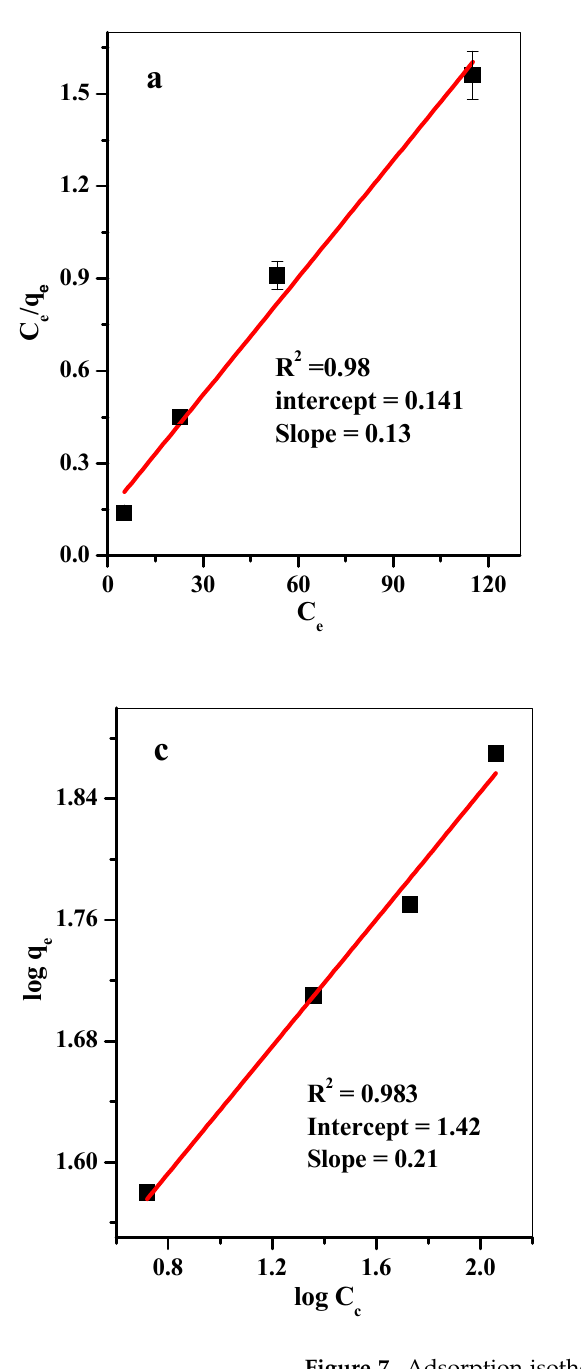
Figure 7. Adsorption isotherms: ( a ) Langmuir isotherm plot ( b ) Freundlich isotherm plot ( c ) R L ( d ) Tempkin isotherm plot for removal of MB dye (t = 42. s, ([MB] = 100–300 ppm, [dose] = 25 mg/10 mL, pH = 7, T = 25 °C). Table 5. Calculated equilibrium constants for adsorption of MB. Adsorbent